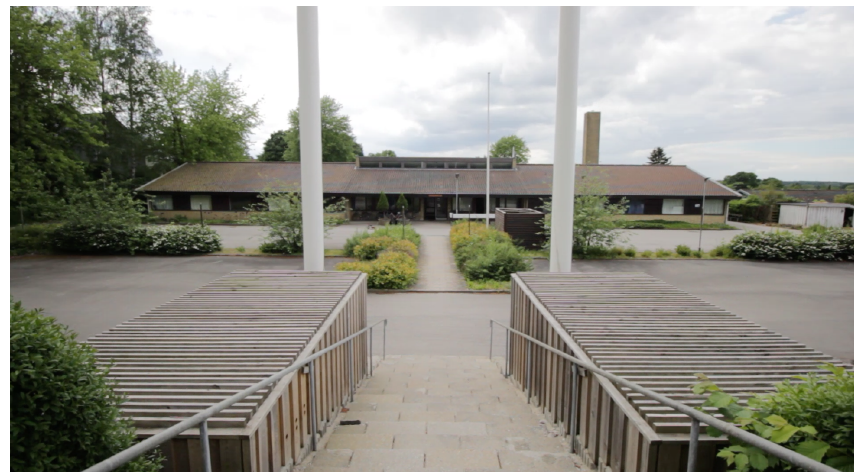
Figure 1. Former retirement home as seen from the street. May 2017.